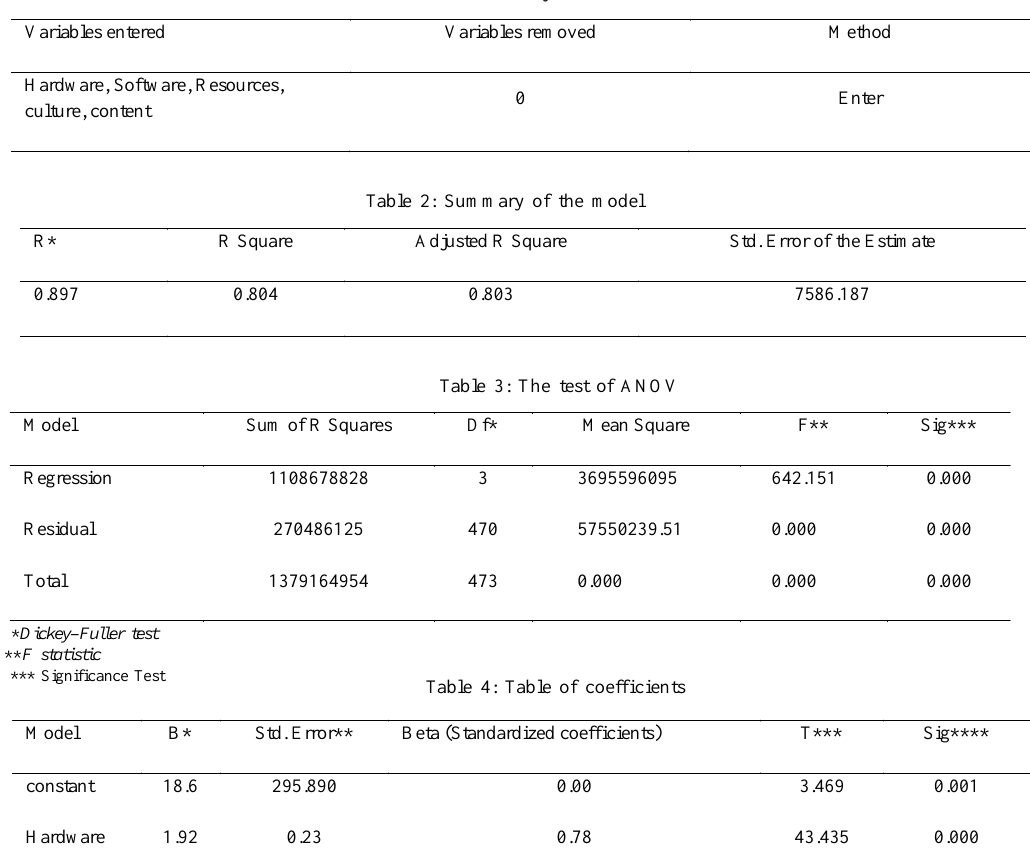
Table 1: The study variables